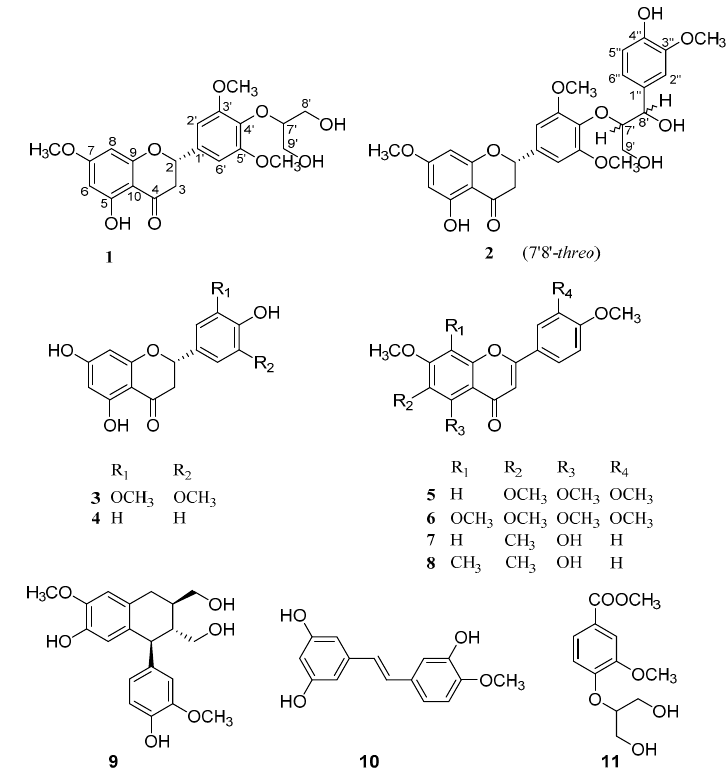
Figure 1. Chemical structures of 1 to 11 .